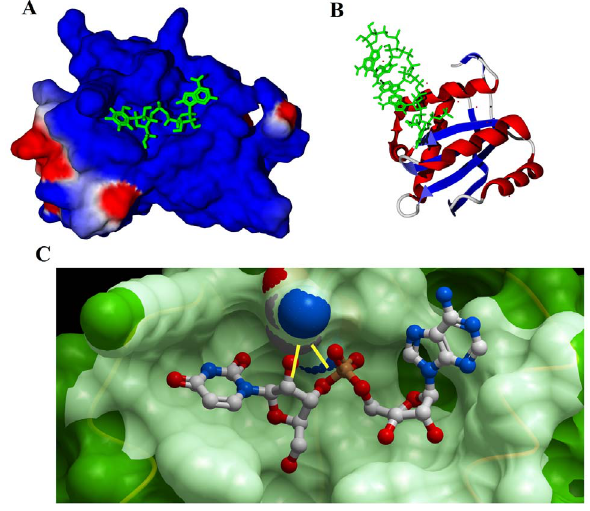
Figure 4. Surface representation of the interaction of nucleo- tides with PAZ domain of Drosophila. Accessible surface representation of the Drosophila Ago2 PAZ domain showing the binding cavity of the Ago2 PAZ domain bound with CMP at its 3 9 - terminal (A). Ribbon representation of the PAZ domain bound with siRNAis shown in (B). Hydrogen bonds (shown in yellow) between the ribose of CMP and the side chain of GLN548 (C). The coordinates of interaction were derived from PDB ID 4F3T.